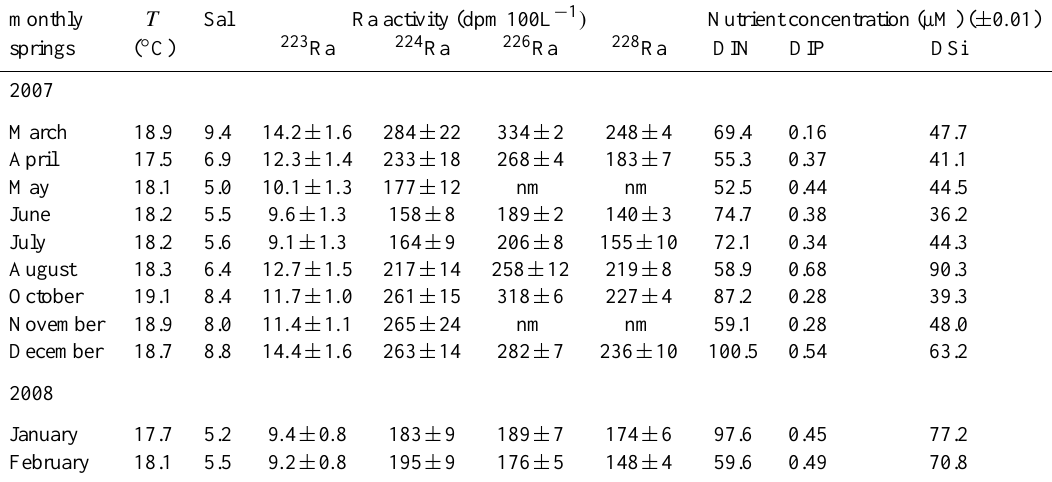
Table 2. Temperature, salinity, radium activities and nutrient concentrations for the monthly collected brackish springs (nm refers to “not- measured samples”). Sal Ra activity (dpm100L − 1 ) Nutrient concentration (µM) ( ± 0 . 01)